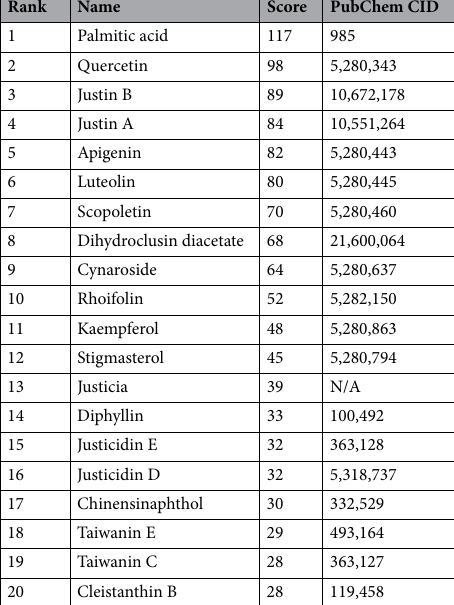
Table 1. Top 20 nodes in Merged Network constructed by Herb-Compounds-Prediction targets.